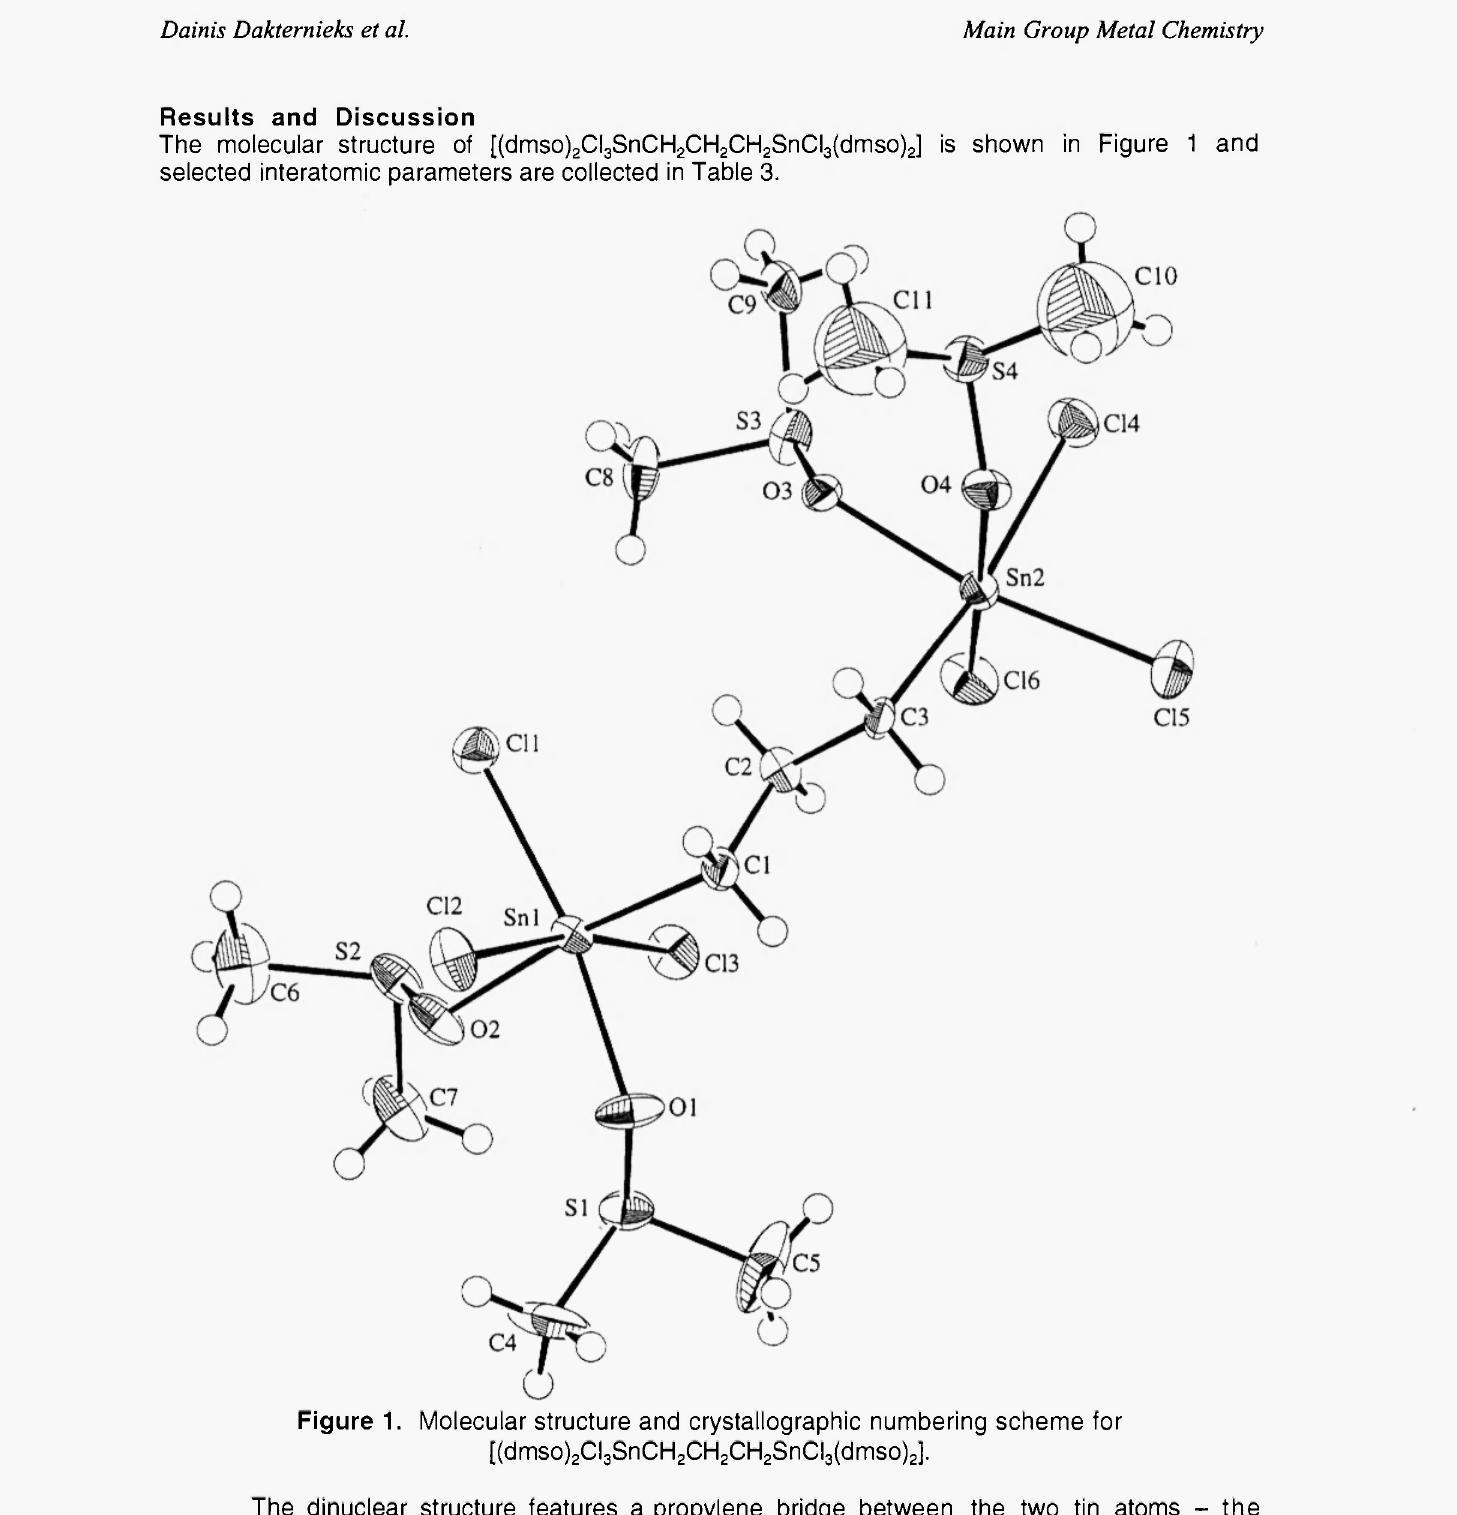
Figure 1. Molecular structure and crystallographic numbering scheme